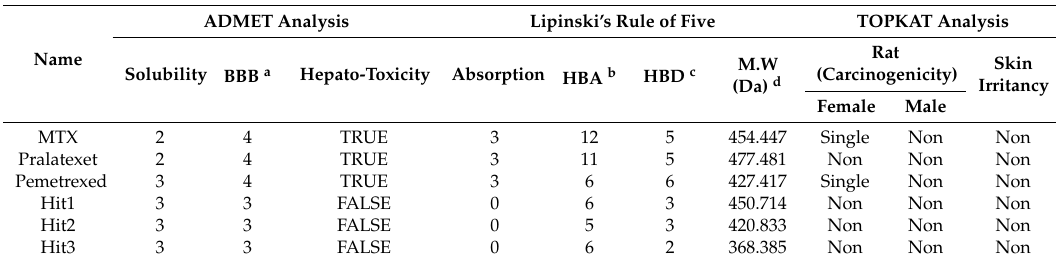
Table 8. Comparison of absorption, distribution, metabolism, excretion, and toxicity (ADMET), Lipinski’s rule of five, and toxicity prediction by komputer assisted technology (TOPKAT) predictions for Federal Drug Agency (FDA) approved drugs and hit